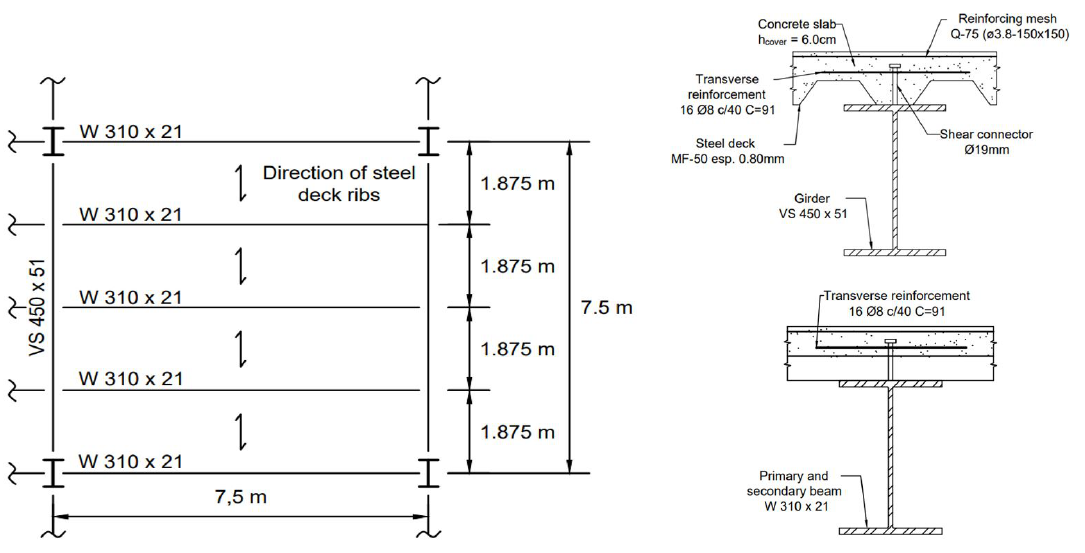
Figure 4. Optimal geometry of the floor system for example